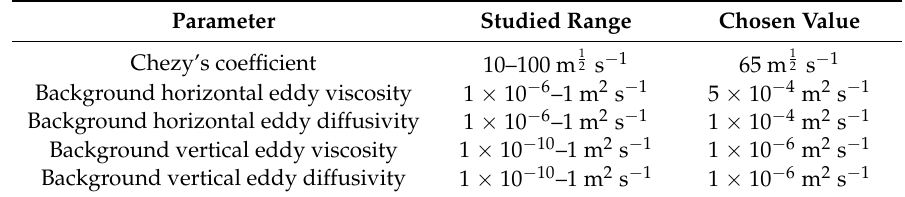
Table 1. Parameters studied for the calibration of the Jinghong Reservoir model and their chosen